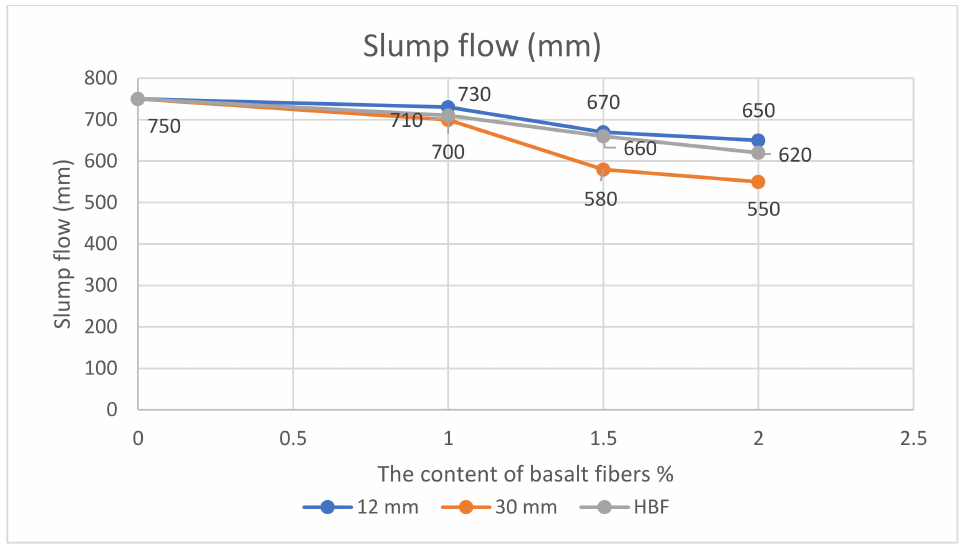
Figure 7. Slump flow value for all